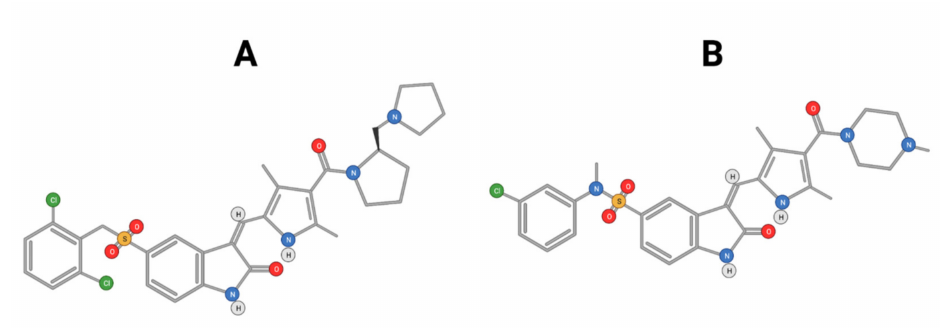
Figure 5. Chemical structure of PHA665752 ( A ) and SU11274 ( B )